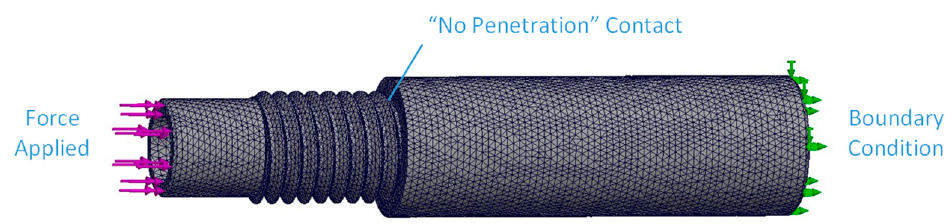
Figure 11. Visualization of the mesh, boundary conditions, and force applied in the finite element model of the instrumented device.